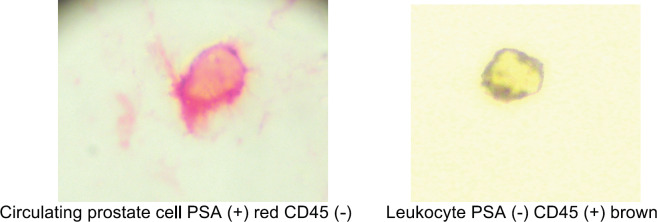
Circulating prostate cell and leukocyte.